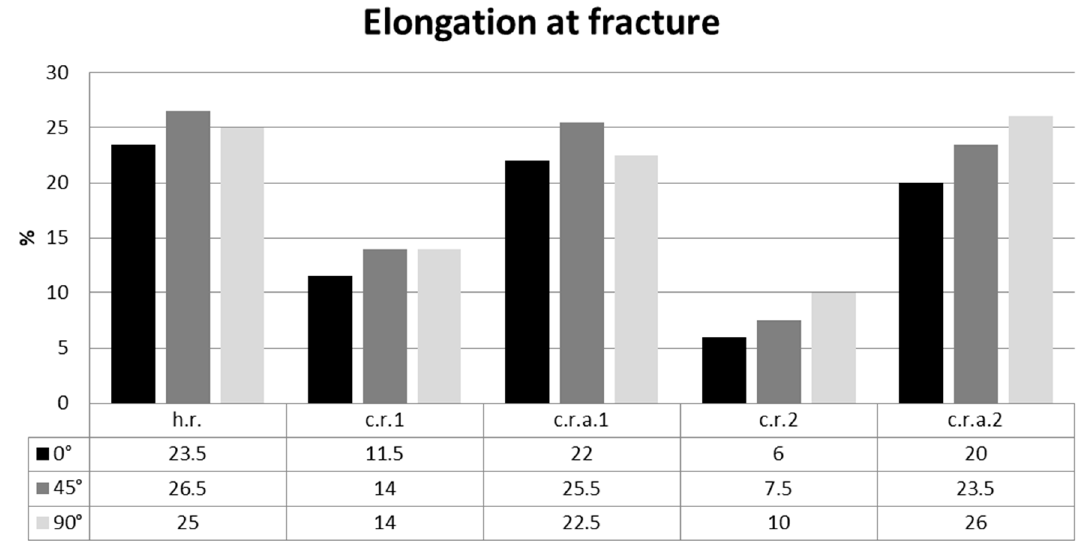
Figure 8. Elongation at fracture data for all products and conditions.